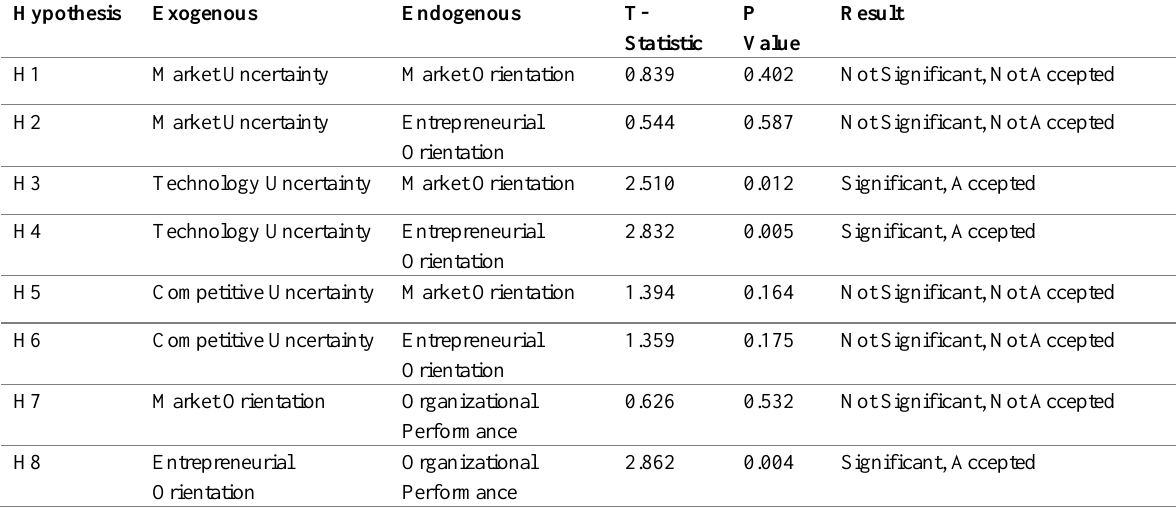
Table 2: Results of Direct Effect Hypothesizes Testing